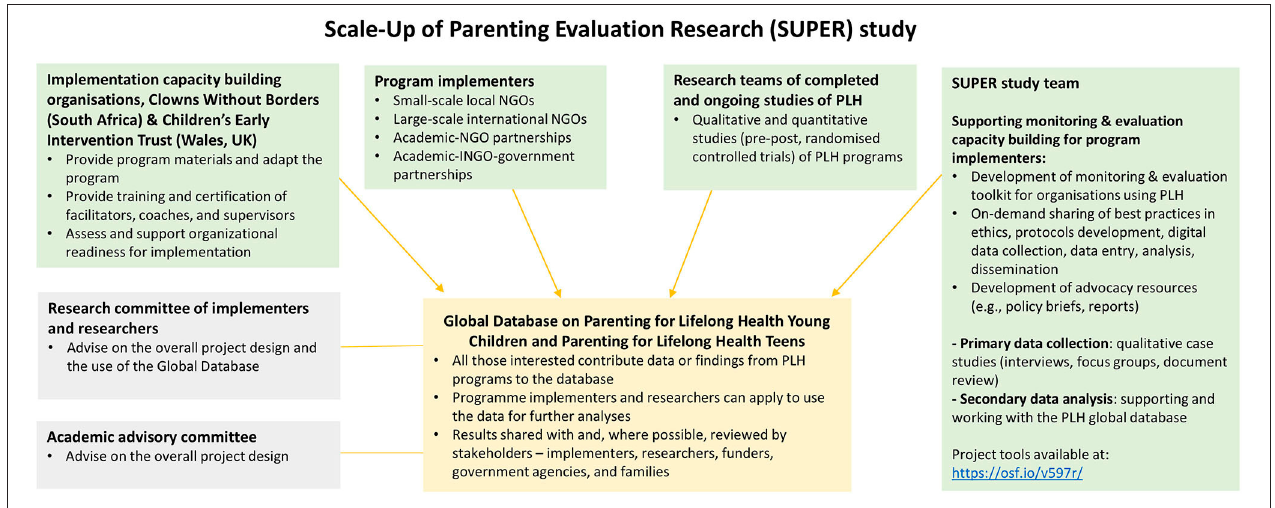
FIGURE 1 | Overview of the collaborations linked to the SUPER study.